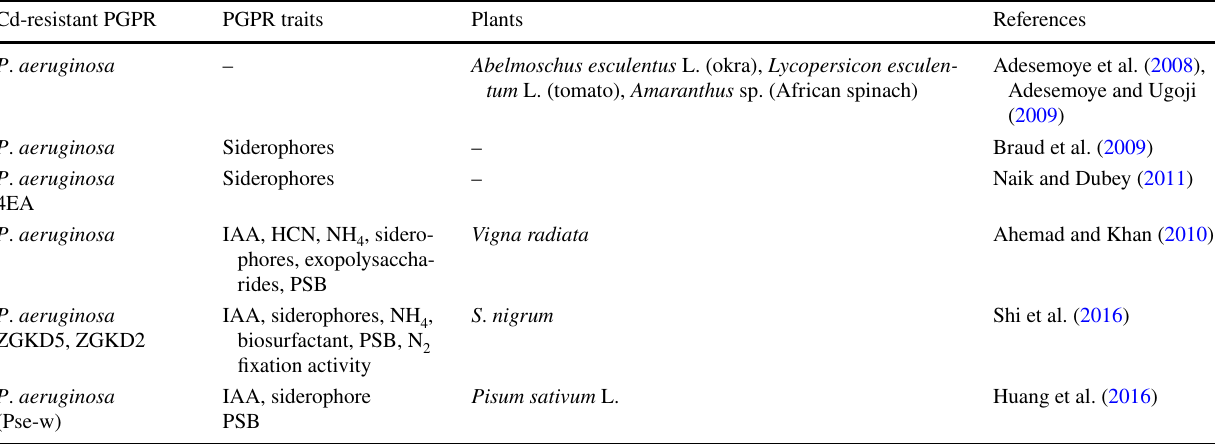
Table 3 PGPR characteristics of Cd-resistant Pseudomonas aeruginosa